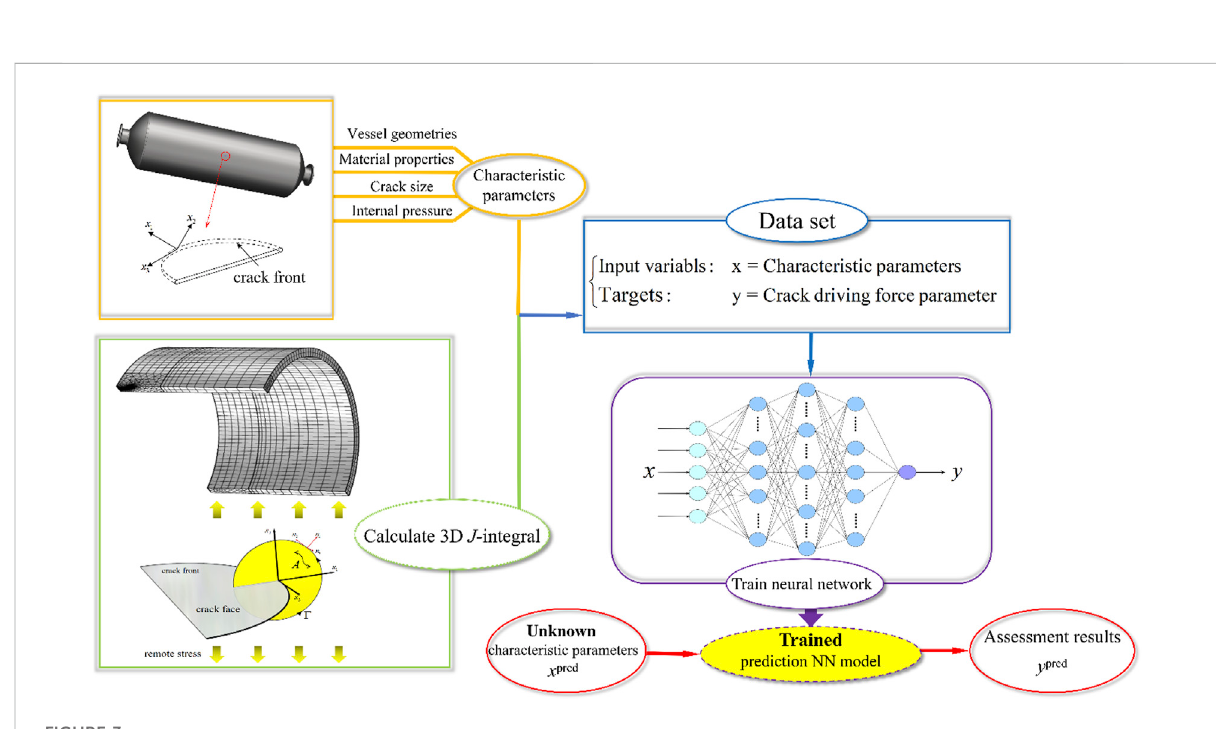
FIGURE 3 Flow diagram of safety